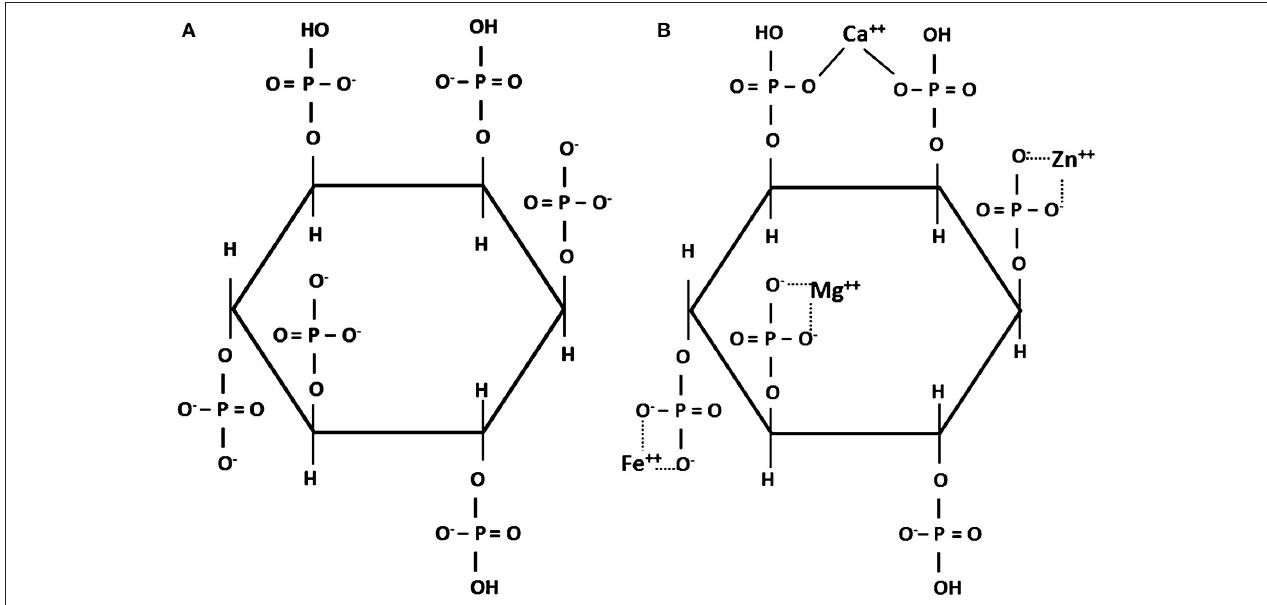
FIGURE 1 | (A) Structure of phytic acid at neutral pH (14); (B) phytate chelate with different cations.